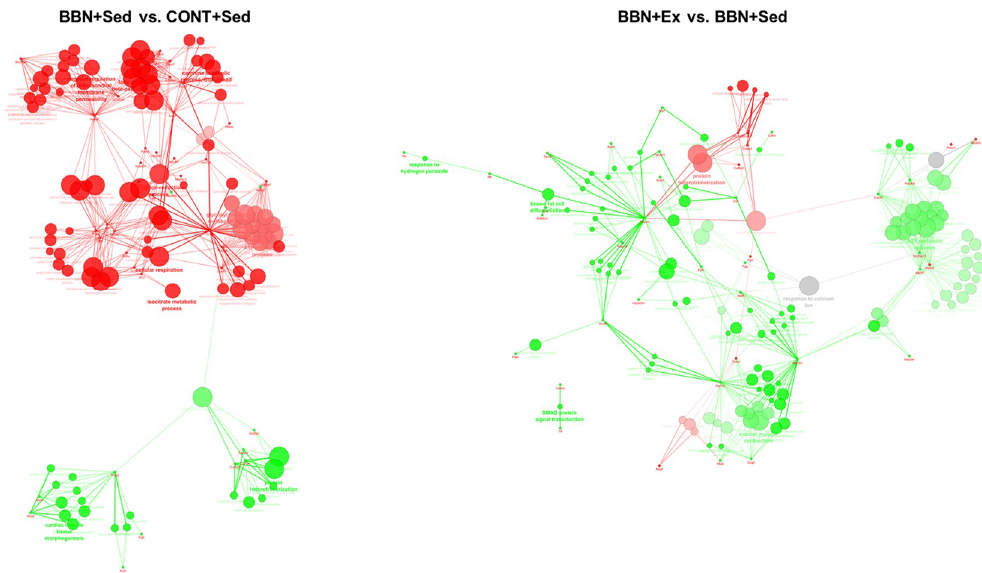
Figure 6. ClueGo + CluePedia analysis of protein-protein interaction considering unique proteins and the ones present in significantly distinct levels (based on emPAI values) in the heart of CONT+Sed and BBN+Sed, and BBN+Sed and BBN+Ex animals. In BBN+Sed vs. CONT+Sed analysis, green nodes up-regulated in the CONT+Sed group. In BBN+Ex vs. BBN+Sed analysis, green nodes refer to